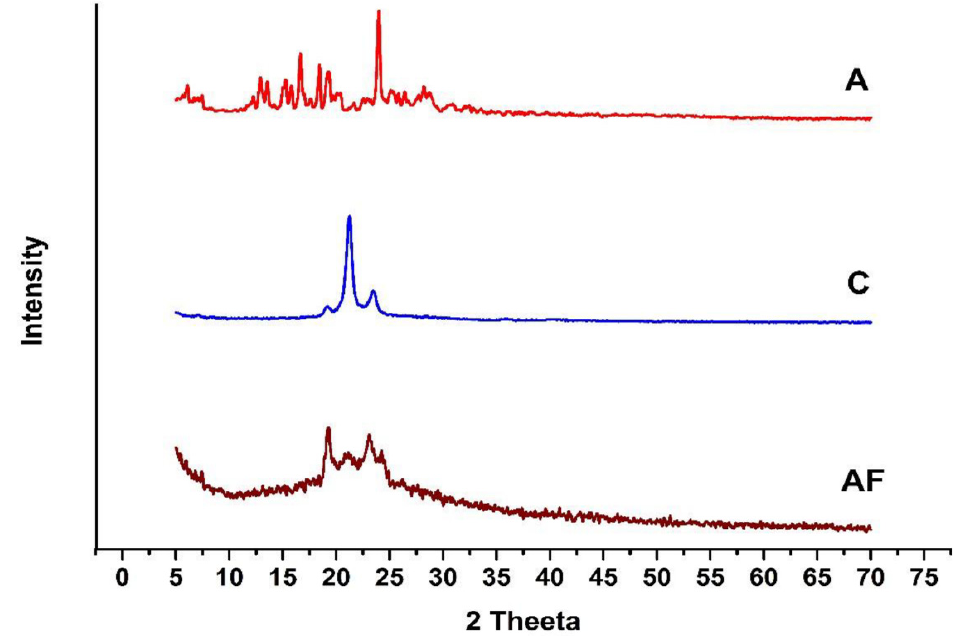
Figure 7. X-ray diffractogram for A (alprazolam), C (compritol), and Figure 7. X ‐ ray diffractogram for A (alprazolam), C (compritol), and AF6.